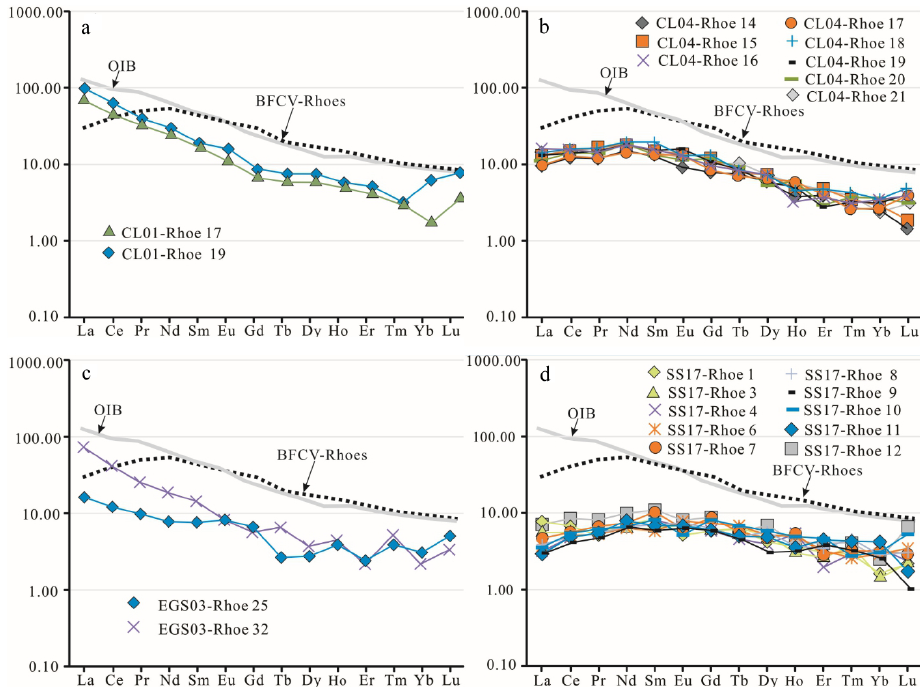
Figure 7. REE contents of Changle rhönite normalized to chondrite (Sun and McDonough, 1989) and compared to literature data. BFCV– Rhoes is rhönite from the islands of Bravo and Fogu, Capo Verde archipelago, from Kogarko et al. (2005); OIB is ocean island basalt from Sun and McDonough